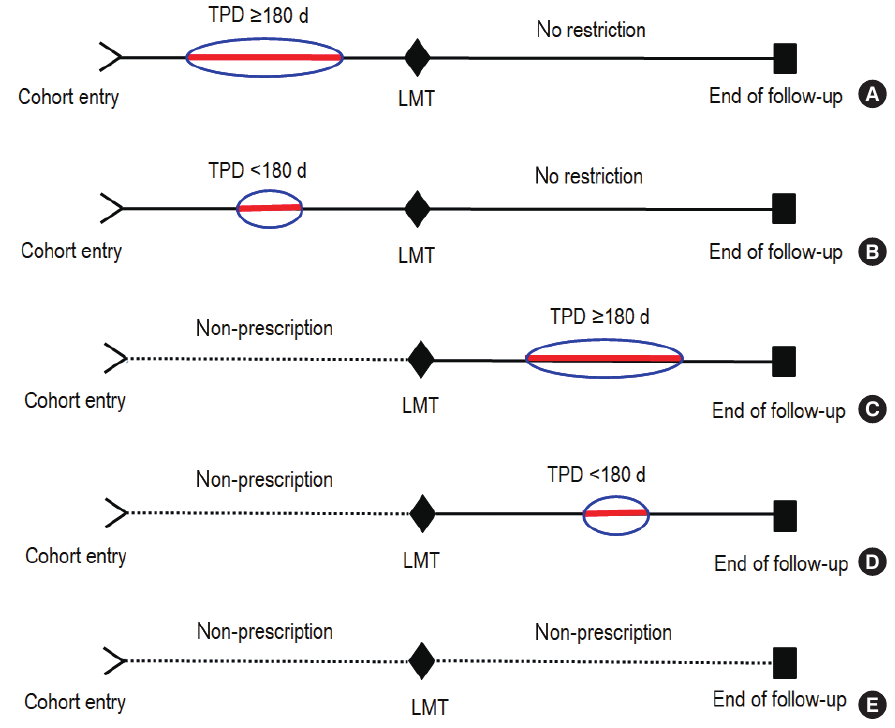
Figure 2. Medication prescription status; (A) early prescription with compliance, (B) early prescription with poor compliance, (C) late pre- scription with compliance, (D) late prescription with poor compliance, and (E) no prescription ever. TPD, total prescription days; LMT, land- mark